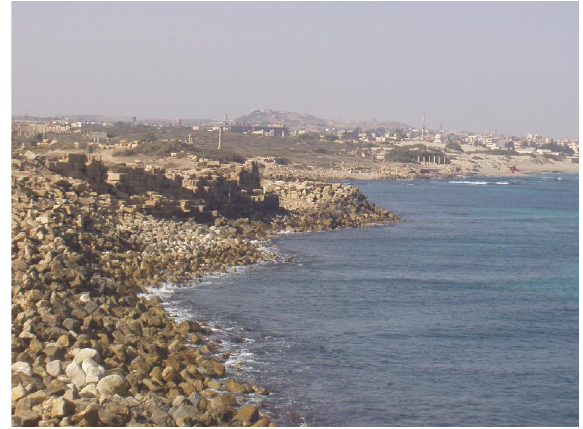
Figure 4. Vi ew of the coast of Leptis